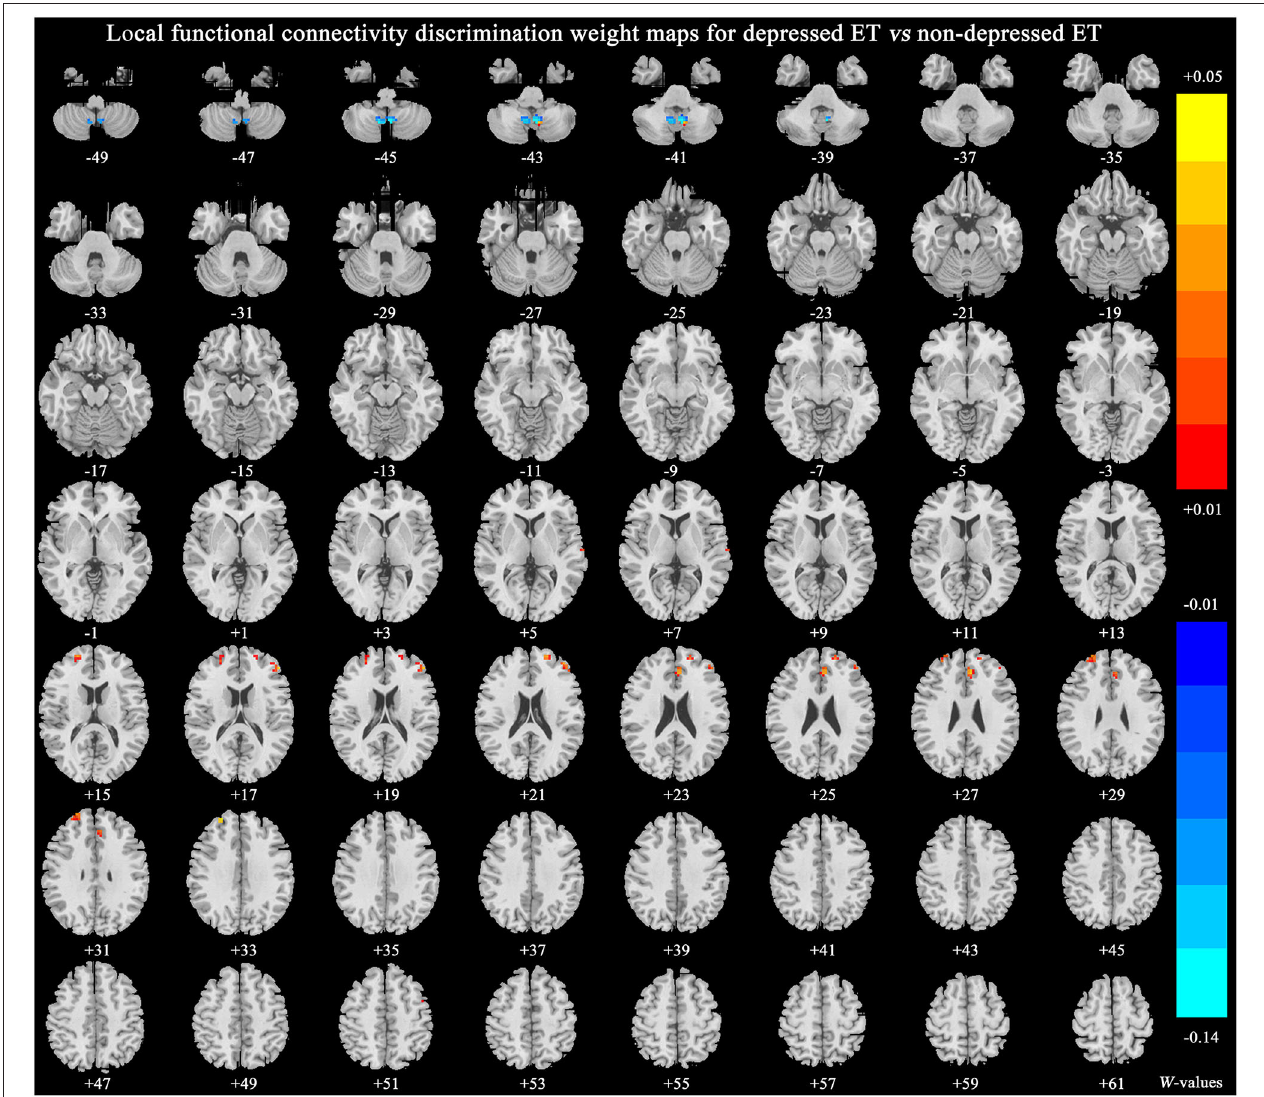
FIGURE 4 | The brain regions of significant discriminative features in the classification of depressed ET vs. non-depressed ET. ET, essential tremor; HCs, healthy